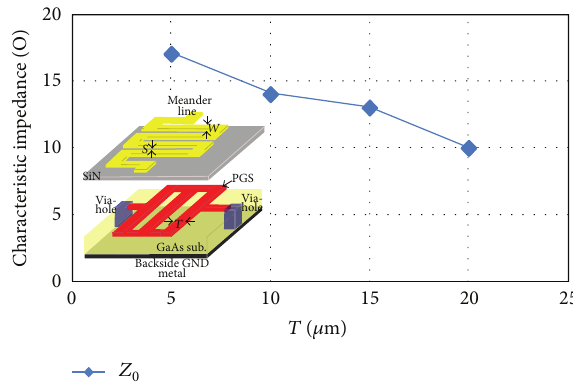
Figure 2: Characteristic impedance of the MLEPGS according to variation of width of 𝑇